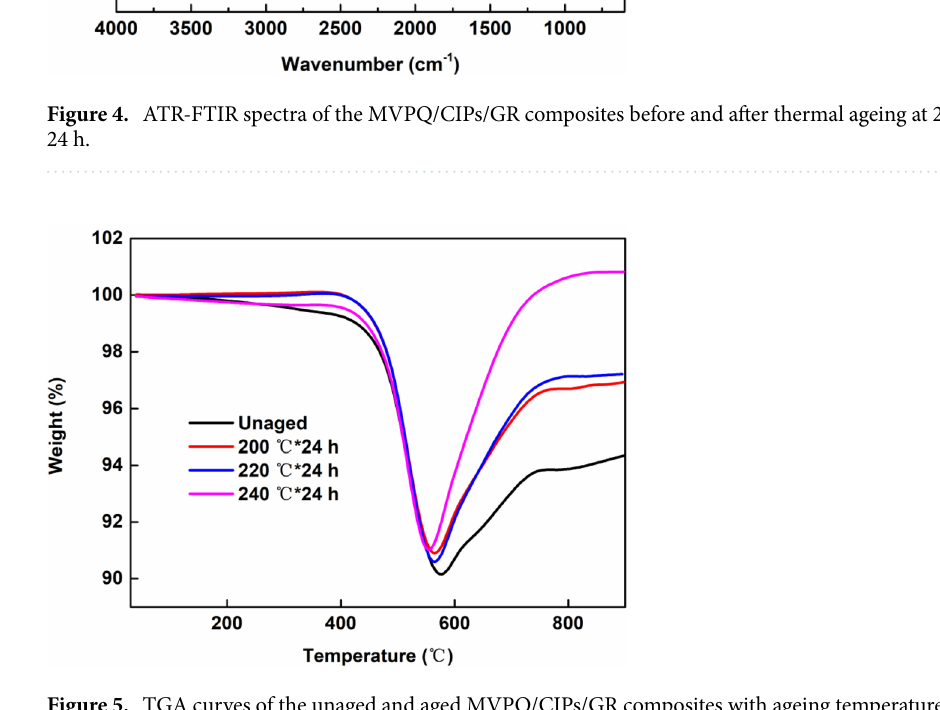
Figure 5. TGA curves of the unaged and aged MVPQ/CIPs/GR composites with ageing temperatures of 200, 220 and 240 °C for 24